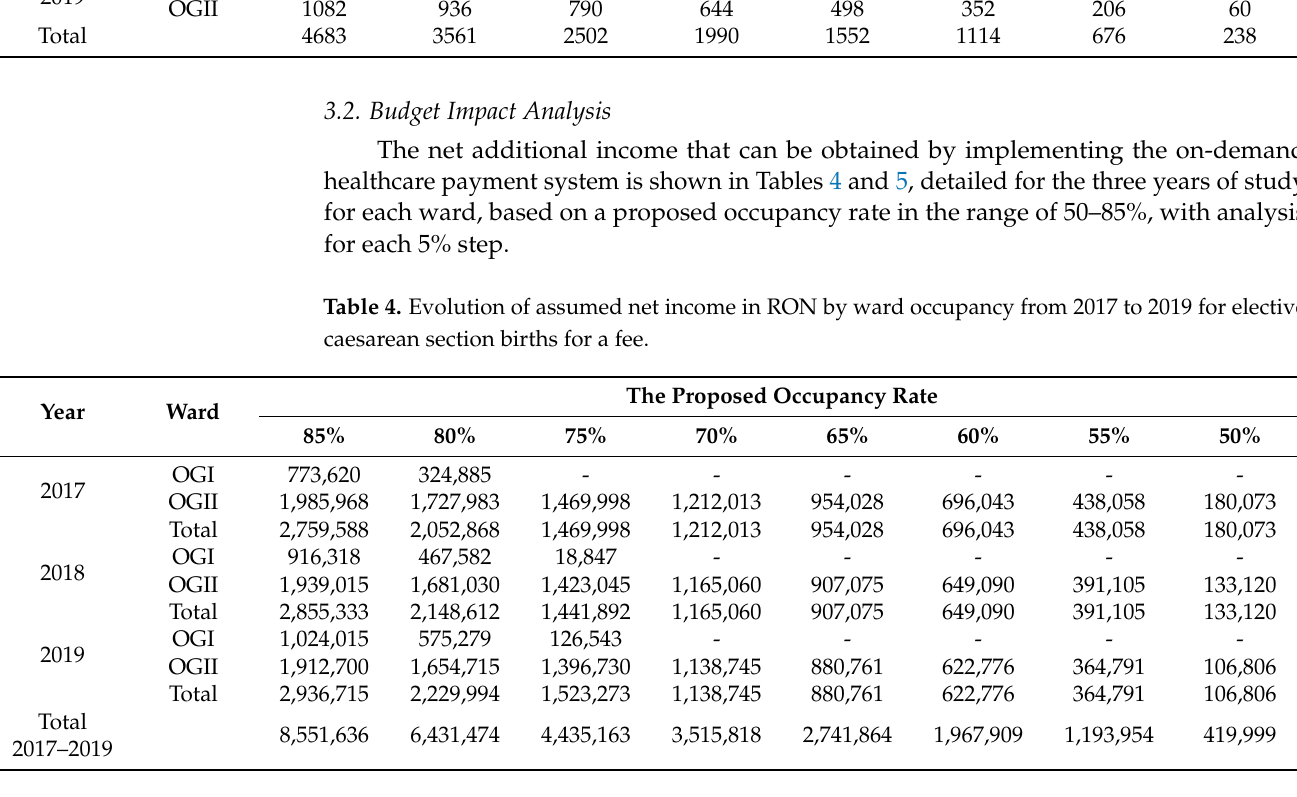
Table 5. Evolution of assumed net income in EUR, by ward occupancy from 2017 to 2019 for elective caesarean section births for a